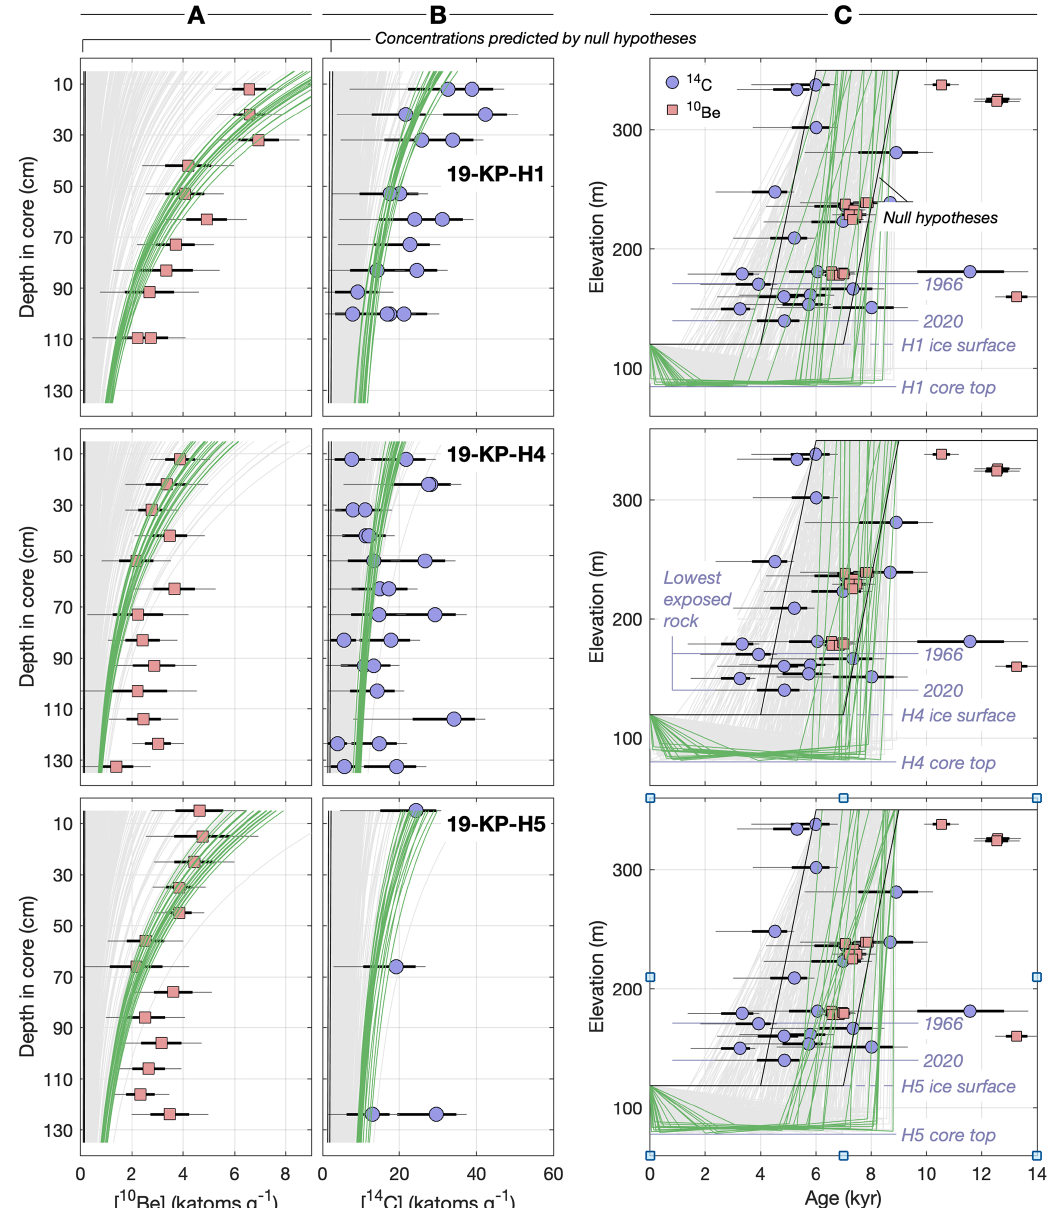
Figure 7. 10 Be and 14 C concentrations in core samples compared to the null hypothesis for zero Holocene thinning and to results of the random search algorithm. Columns (a) and (b) compare measured and predicted in situ 10 Be and 14 C concentrations in quartz in three subglacial bedrock cores. Green and gray lines show concentrations predicted by ice thickness change histories generated by the random search algorithm that best fit data from each core. Results shown in green are the best-fitting 1% of the random search iterations, and others are shown in gray. Likewise, column (c) compares the thickness change histories that do and do not fit the core data to 10 Be and 14 C exposure-age data from above the present ice surface on the north ridge of Kay Peak. The same exposure-age data are redundantly shown in all three panels in column (c) . The 26 Al data for core 19-KP-H1 are equivalent to 10 Be results and are omitted here for clarity (Methods 3 in the Supplement). In all plots, the 68% and 95% confidence intervals on nuclide concentrations and exposure ages are shown as thick and thin error bars. Black lines labeled “Null hypotheses” represent a range of variations on a null hypothesis scenario in which the ice sheet thins rapidly to its present thickness in the Early to Middle Holocene and does not change thereafter. Predicted nuclide concentrations for the null hypothesis are also shown as black lines in columns (a) and (b) (very close to the y axes), highlighting that they are not consistent with observed